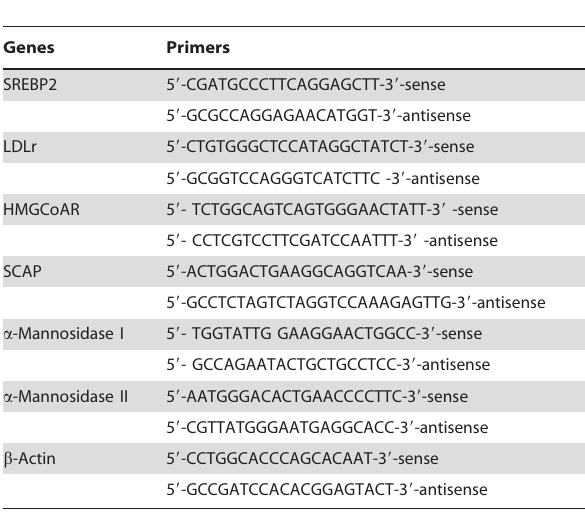
Table 1. The primers for real-time